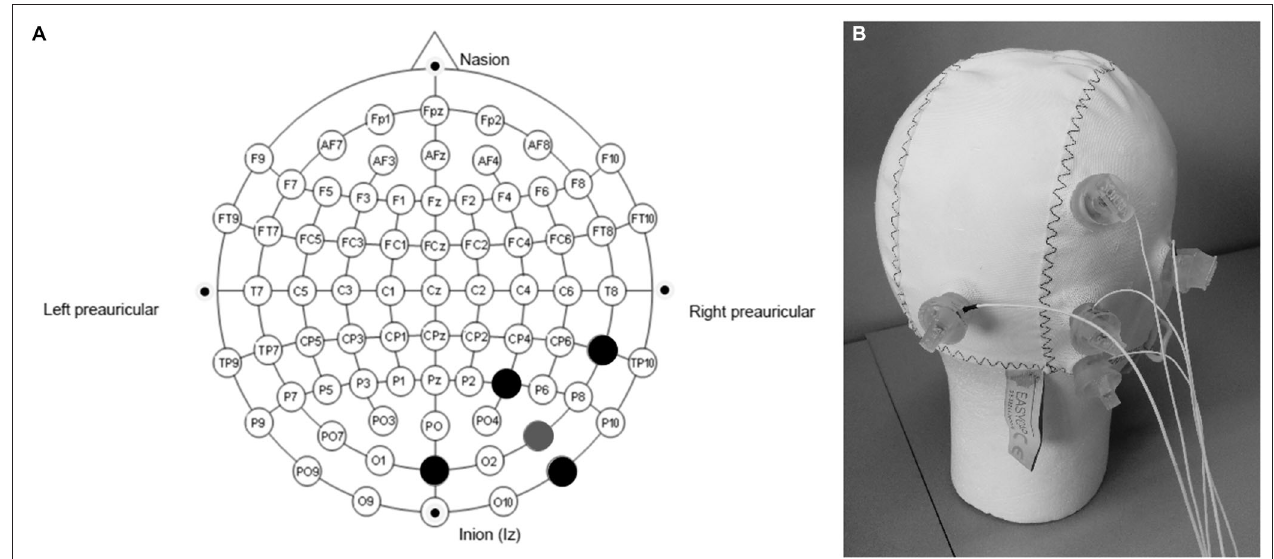
FIGURE 3 | Electrodes montage for the High Definition transcranial direct current stimulation (HD-tDCS) experiment. (A) the gray point represents the central electrode, placed over PO8; the black points represent the other four (return) electrodes, placed over P4, OZ, TP8 and PO10. (B) Easycap, with electrodes placed according to the selected